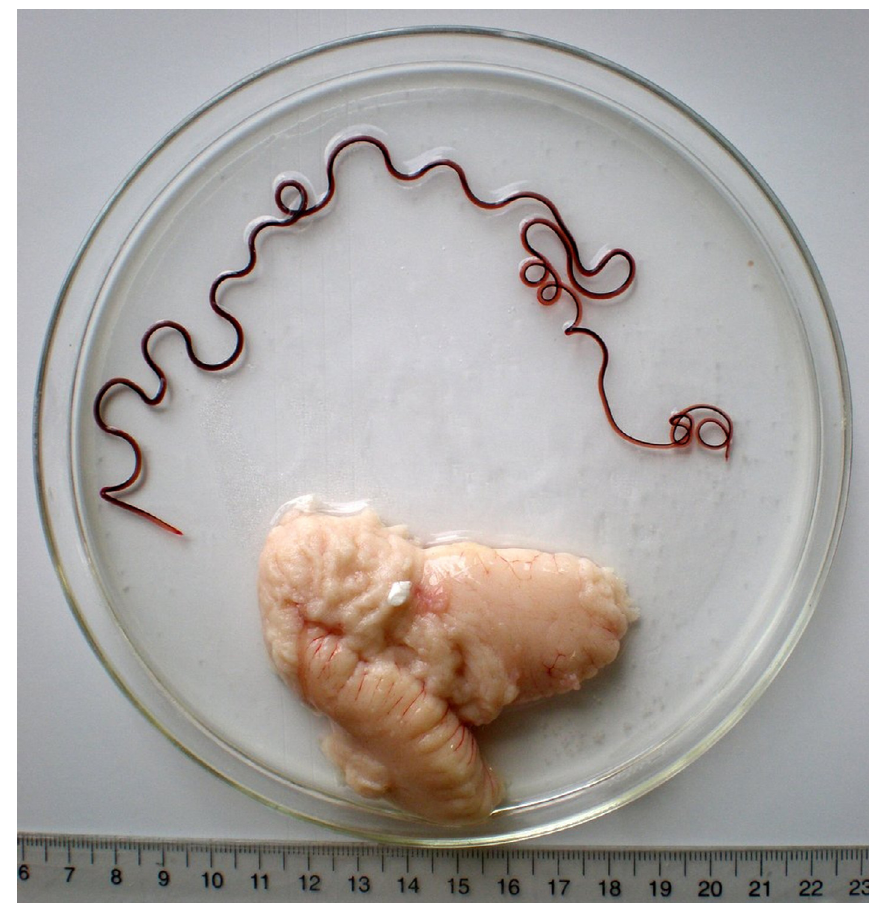
Figure 7. Philometra fasciati gravid female removed from the ovary of E . fasciatus . Scale: centimetres and